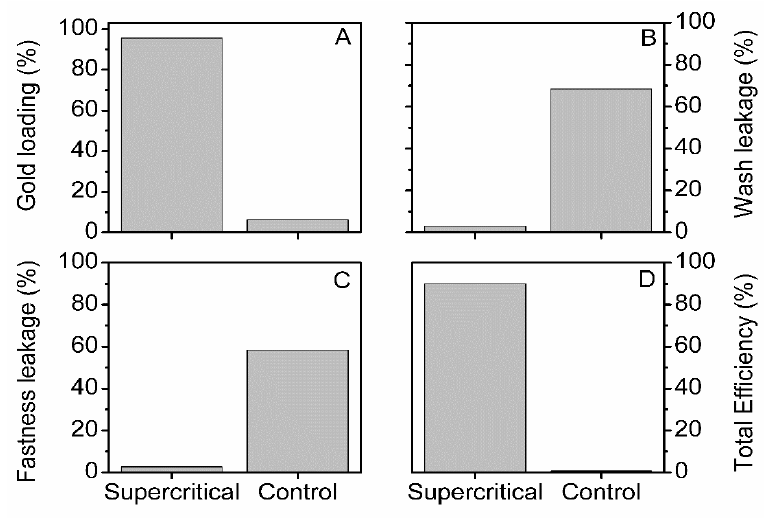
Figure 6. Comparative gold loading (%)—( A ), wash leakage (%)—( B ), fastness leakage (%)—( C ), and total efficiency (%)—( D ), for supercritical impregnated and control degummed silk fibers. See the materials and methods for details.